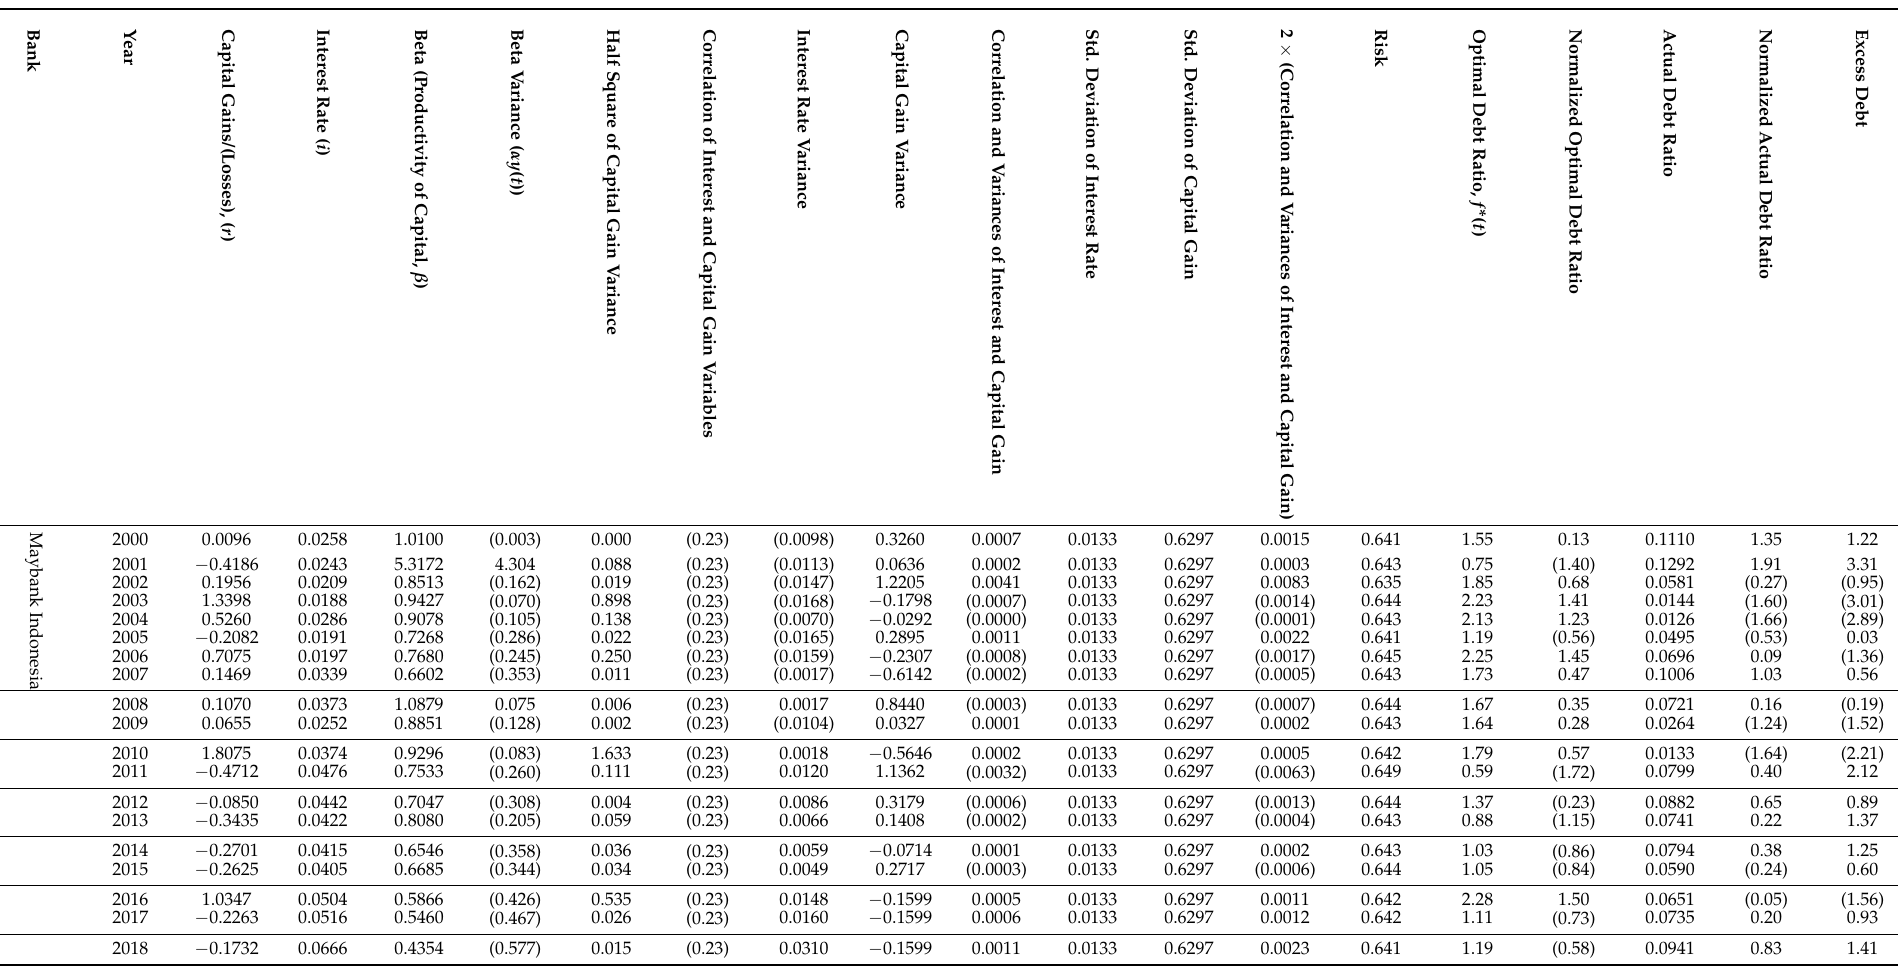
Table A9. Calculations of Optimal and Excess Debt: Maybank